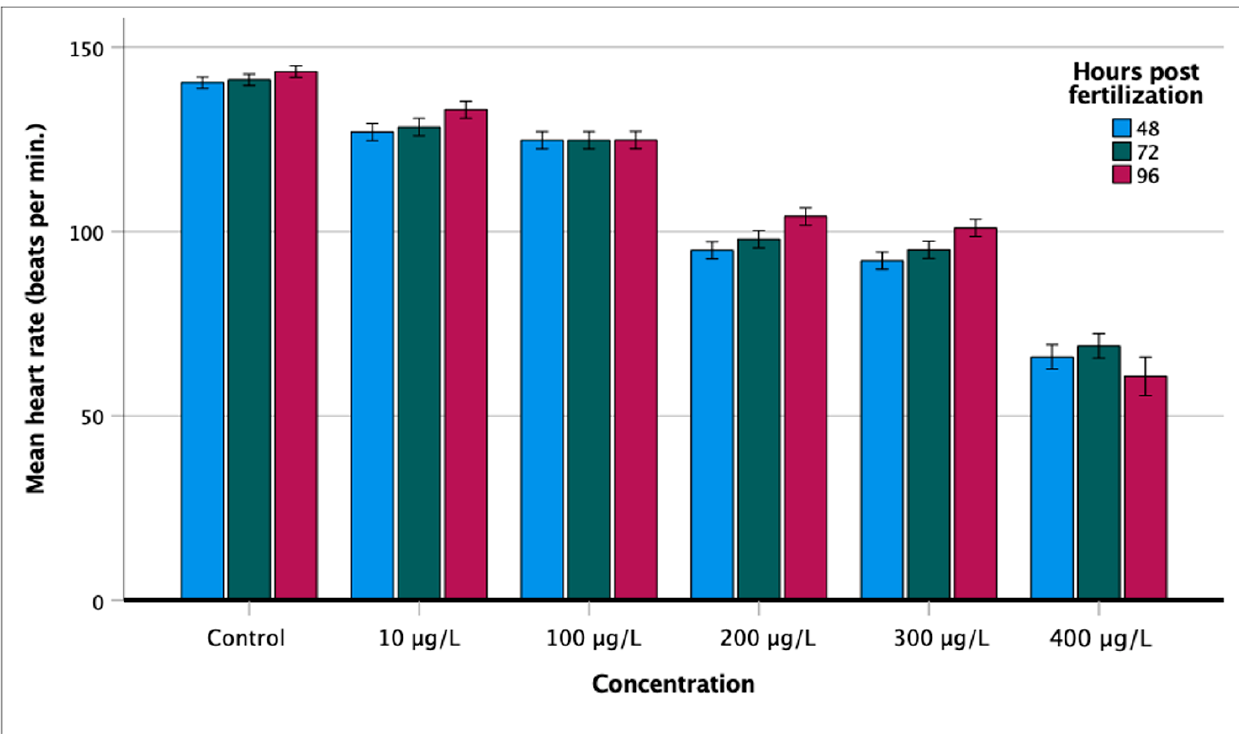
Figure 2. Heartbeat rate of zebrafish during embryonic development, upon exposure to various concentrations of 2,6-DCBQ-OH, at 48, 72, and 96